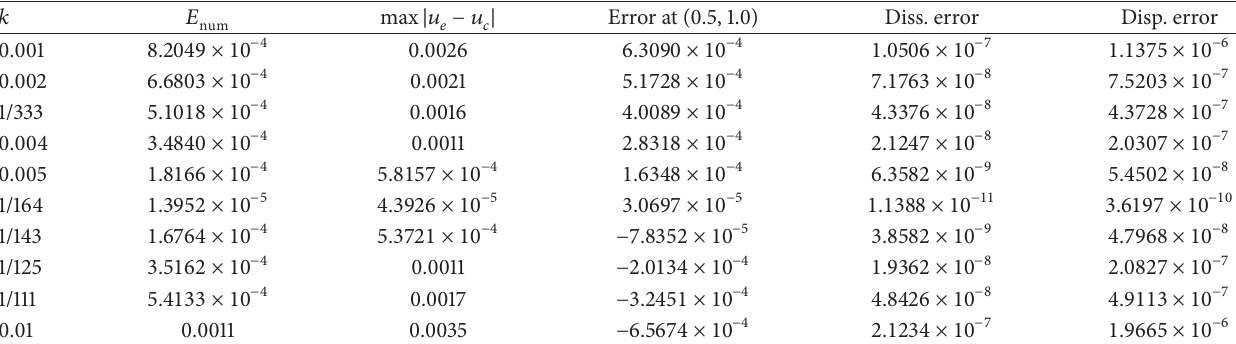
Table 4: Errors for the Lax-Wendroff scheme for ℎ = 0.02 .